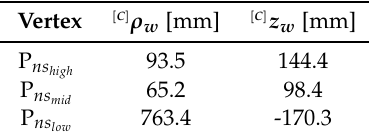
Table 3. Near Vertices of the SROI for the Big